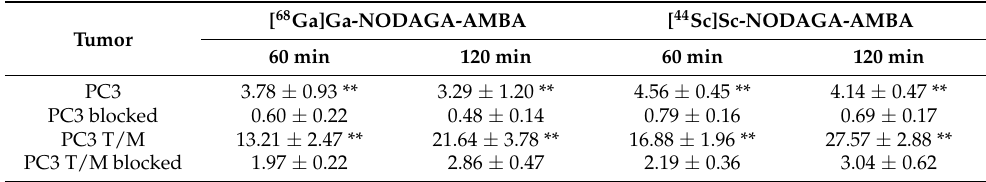
Table 1. Ex-vivo assessment of [ 68 Ga]Ga-NODAGA-AMBA and [ 44 Sc]Sc-NODAGA-AMBA accu- mulation (%ID/g) in PC-3 experimental tumors 60 and 120 min after intravenous tracer injection and 14 ± 1 days after tumor induction. Significance level between non-blocked and blocked tumors: